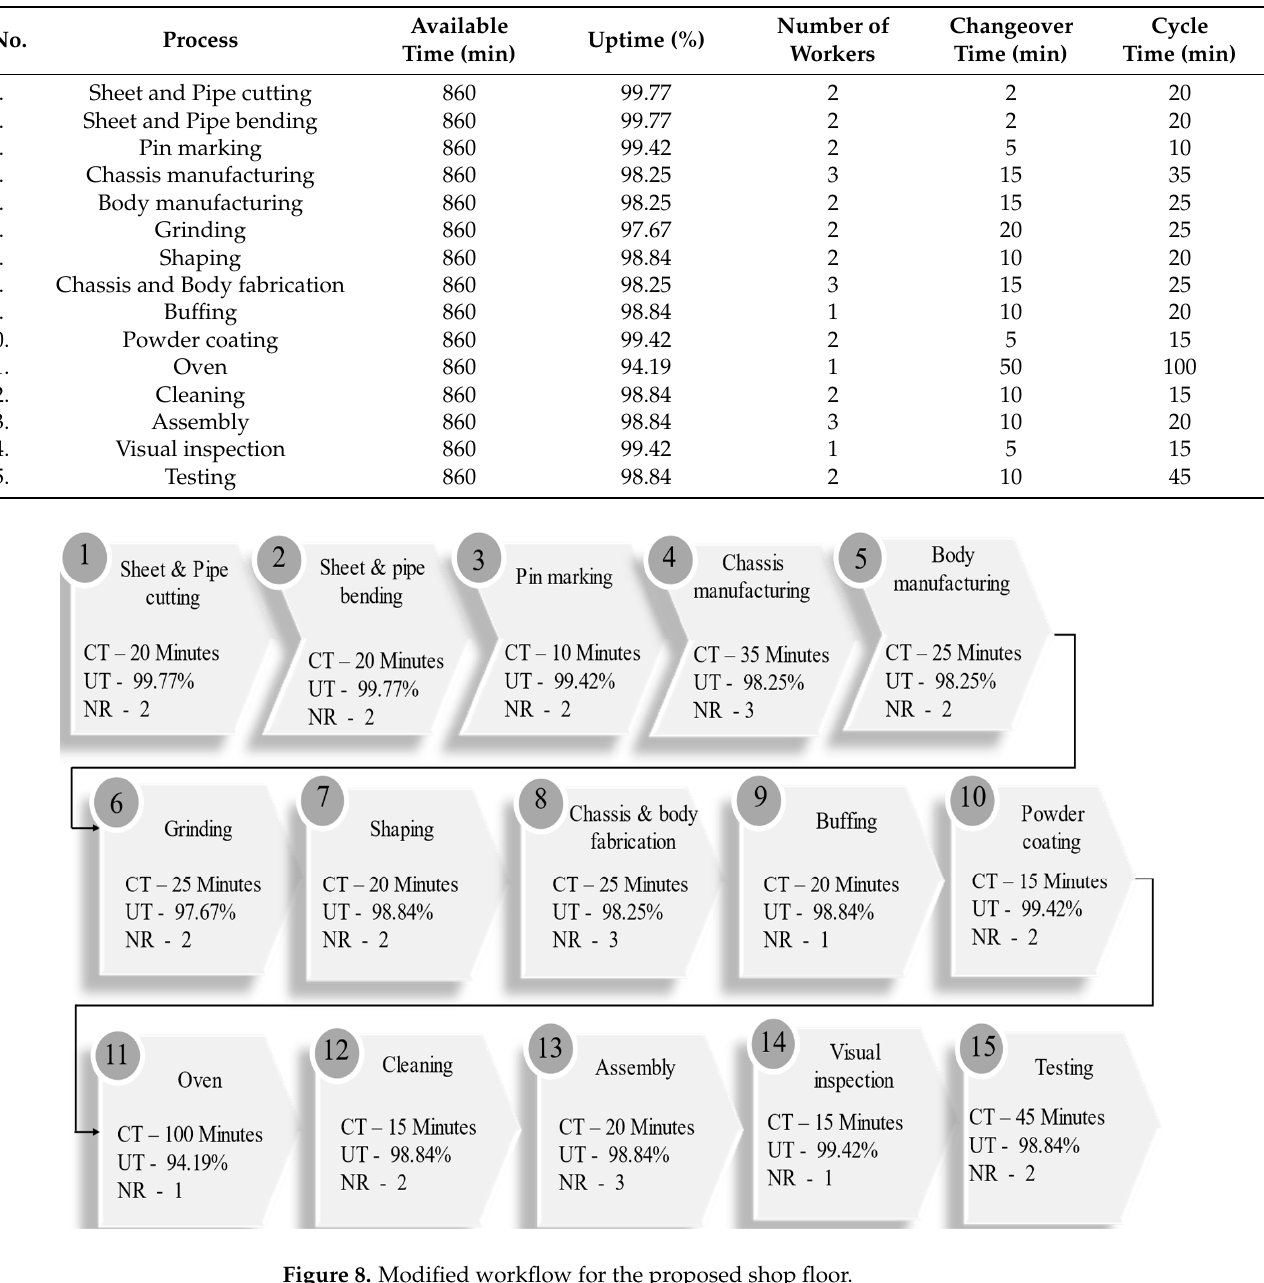
Table 2. Processes and calculated time for the modified shop floor.